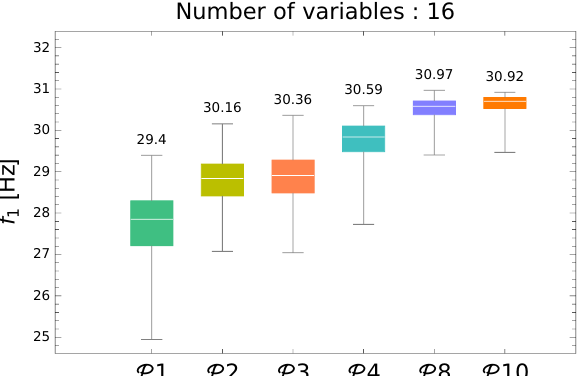
Figure 5. Maximization of f 1 through GA-DNN